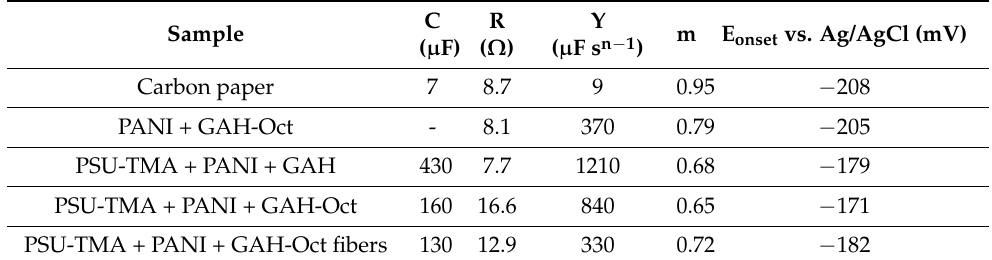
Figure 3. Capacitance determination for ( a ) PSU-TMA + PANI + GAH-Oct fiber electrode; ( b ) other electrodes. Table 1. Electrochemical properties of ORR electrodes: double-layer capacitance, C; resistance, R; CPE value, Y; exponent, m; and onset potential, E onset (see